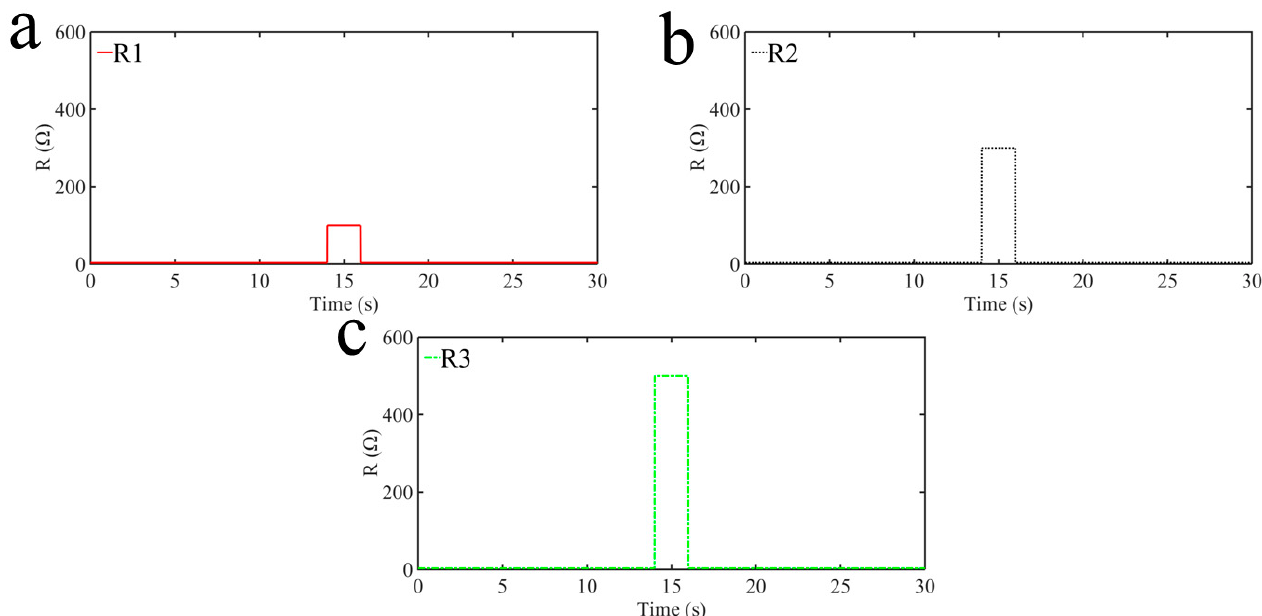
Figure 23. Simulation results with some external disturbances: ( a ) a step signal disturbance of R1; ( b ) a step signal disturbance of R2; ( c ) a step signal disturbance of R3.